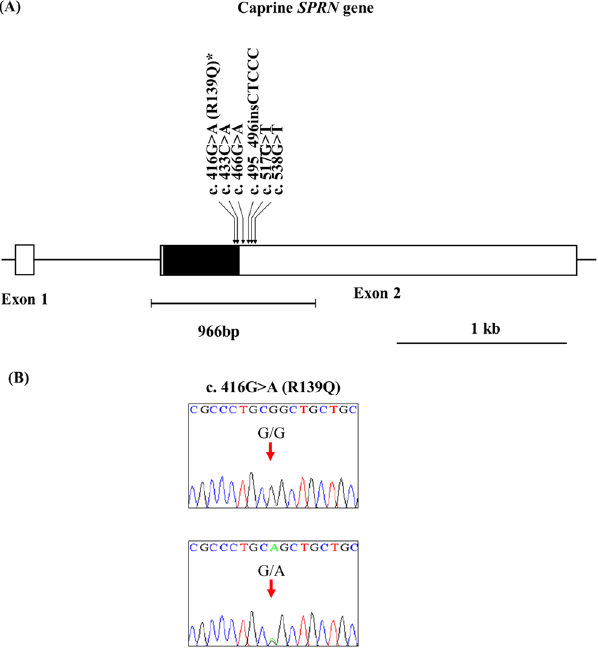
Figure 1. ( A ) Gene map and polymorphisms identified in the shadow of prion protein gene ( SPRN ) on chromosome 26. The open reading frame (ORF) within exon 2 is marked by a shaded block, and the 5 ′ and 3 ′ untranslated regions (UTRs) are indicated by a white block. The arrows indicate the six polymorphisms found in this study. The edged horizontal bar indicates the region sequenced. Asterisks denote novel single nucleotide polymorphisms (SNPs). ( B ) Electropherogram of novel SNPs of the SPRN gene. The four colors indicate individual bases of the DNA sequence using an ABI 3730 automatic sequencer (blue: cytosine; red: thymine; black: guanine; and green: